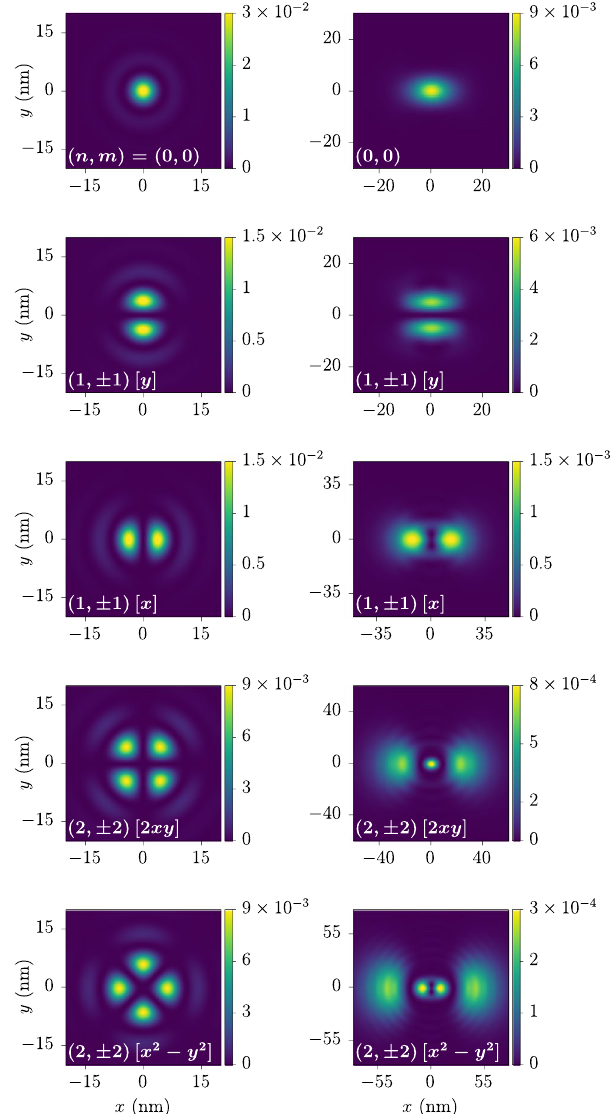
n , m 0 Q . The rows correspond, | ; � ± ; 0 and we take appropriate =